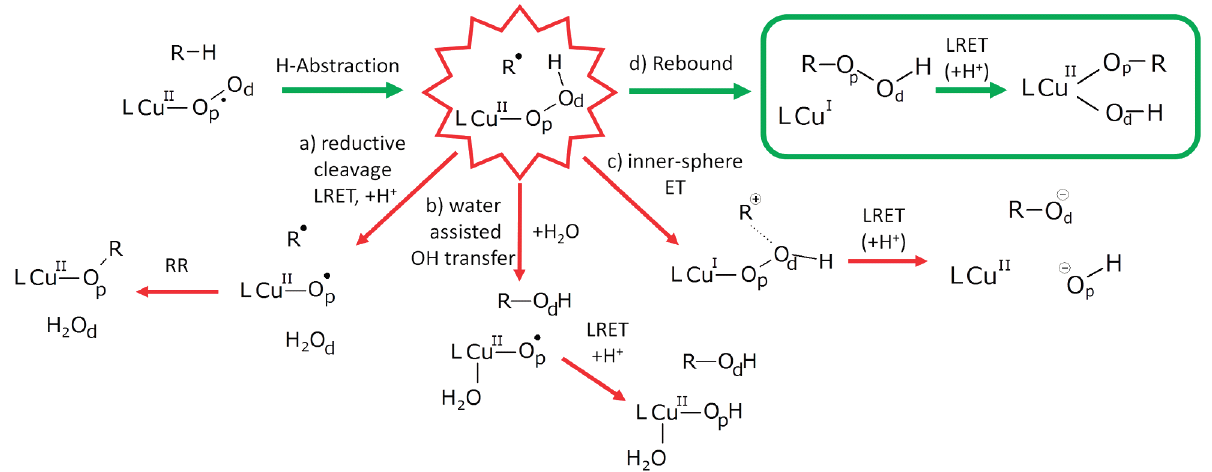
Figure 11. Evolution pathways for the cupric hydroperoxide intermediate: reductive cleavage a) [77], water assisted OH transfer b) [78], inner-sphere ET c) [79], or